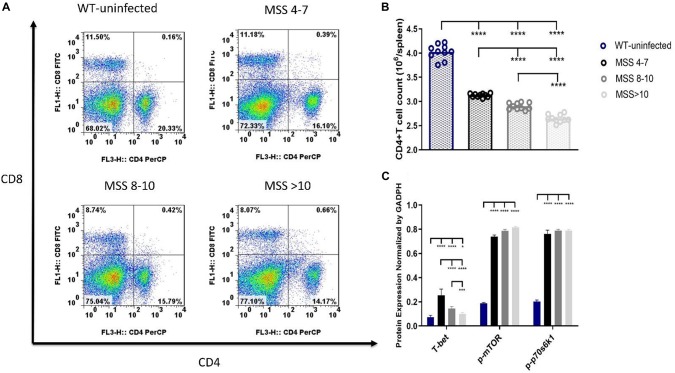
CD4+ T cell count, T-bet expression and mammalian target of rapamycin (mTOR) pathway activation differed according to degrees of sepsis. Splenocytes were obtained at 12 h after Candida injection. (A,B) CD4+ T cells were sorted by flow cytometry analysis. Protein levels of T-bet, phospho (p)-mTOR and p-P70S6 (C) in CD4+ T cells. Levels of T-bet, p-mTOR and p-P70S6 in CD4+ T cells were quantified by western blotting. The amount of each protein level was normalized by GAPDH. Mean ± SD, 10 mice per group, analyzed by one-way analysis of variance multiple comparisons. *P < 0.05, ***P < 0.001, ****P < 0.0001. WT, wild type; (Summarization of the flow cytometry scatter plots was provided in Supplementary Material).